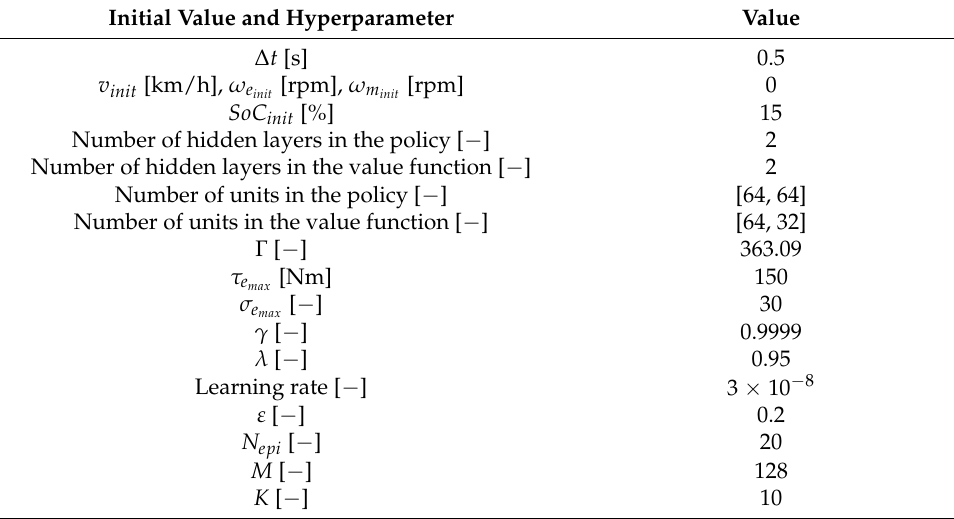
Table 3. The initial values and hyperparameters in the